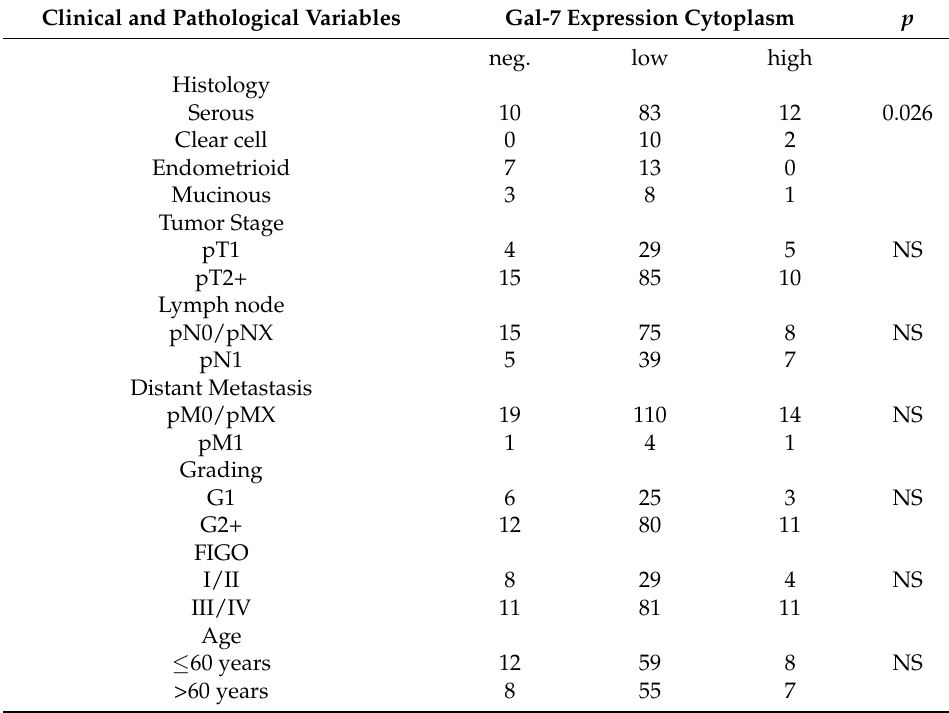
Table 4. Gal-7 staining correlated with clinical and pathological data. Clinical and Pathological Variables Gal-7 Expression